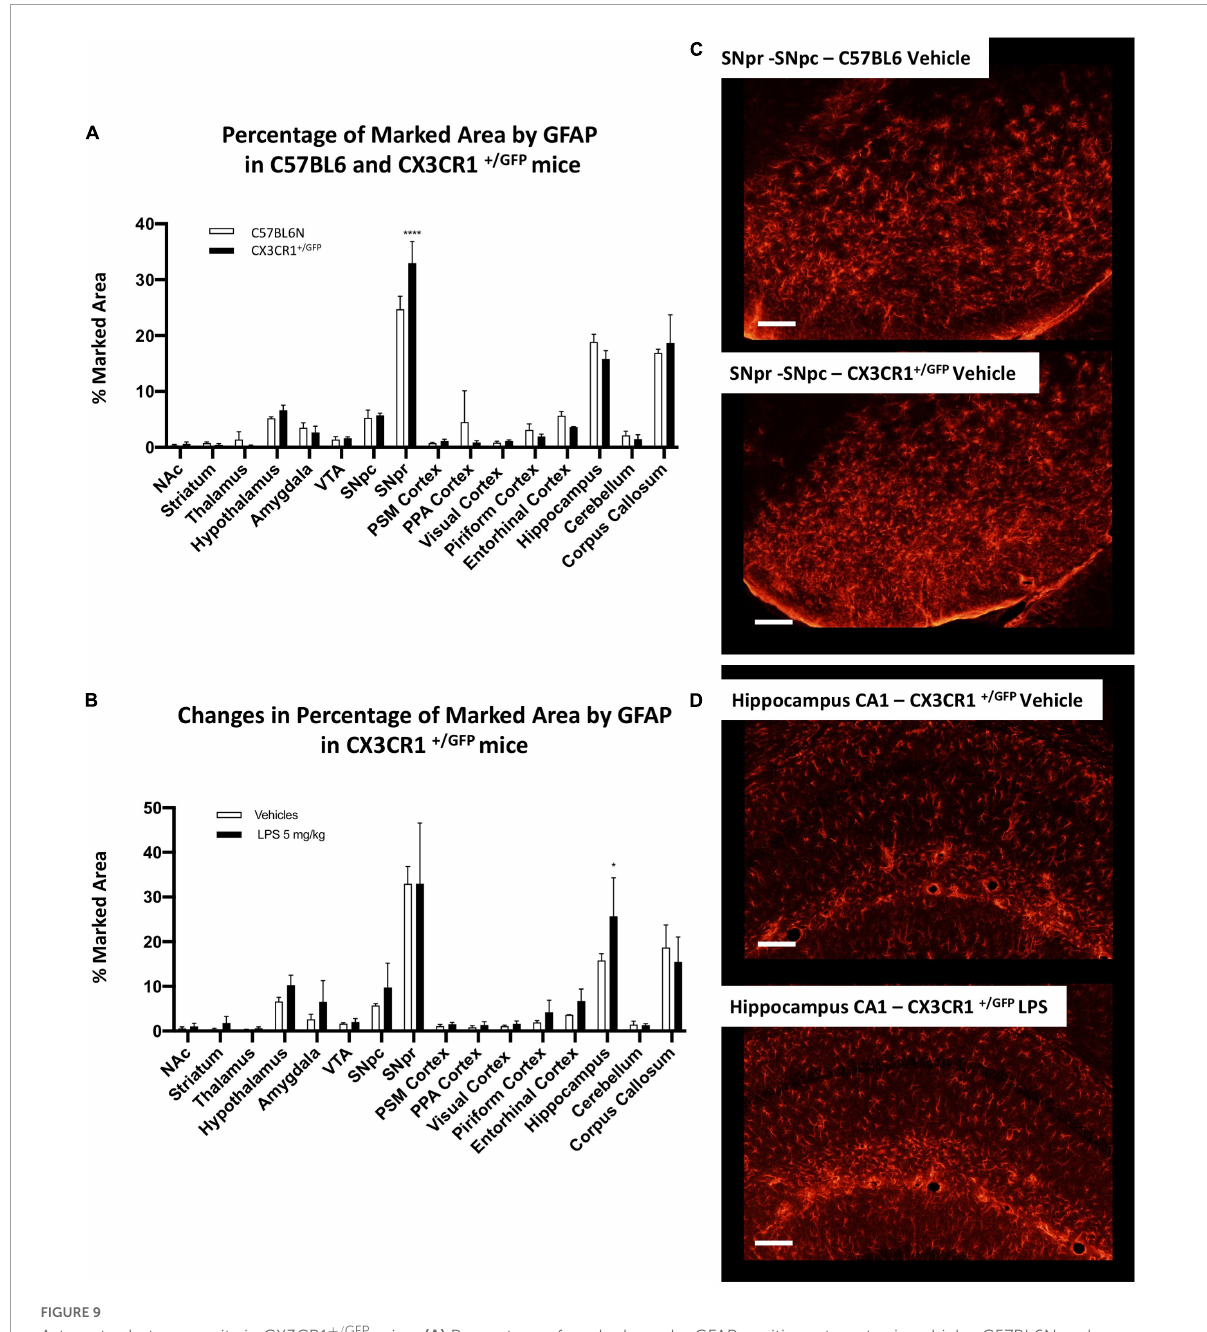
FIGURE9 Astrocytes heterogeneity in CX3CR1 + / GFP mice. (A) Percentage of marked area by GFAP positive astrocytes in vehicles C57BL6N and CX3CR1 + / GFP mice. Two-way ANOVA F BrainRegions (15, 64) = 136.9, p < 0.0001. F Genotype (1, 64) = 0.00128, p < 0.9715. F Interaction (15, 64) = 3.575, p < 0.0002, and n = 3 mice per region. Significance: (*) respect relative regions in C57BL6 mice. (B) Changes in percentage of marked area by GFAP positive astrocytes in CX3CR1 + / GFP mice cells in vehicles (white columns) and LPS treated (black columns). Two-way ANOVA. F BrainRegions (15, 64) = 39.36, p < 0.0001. F Treatment (1, 64) = 5.526, p < 0.0218. F Interaction (15, 64) = 0.9605, p < 0.5055, and n = 3 mice per region. Significance: (*) respect relative vehicles. (C) Confocal images of GFAP positive astrocytes in SNpr in C57BL6 and CX3CR1 + / GFP mice. (D) Representative images of GFAP positive astrocytes in hippocampus of CX3CR1 + / GFP mice treated with 5 mg/kg LPS and relative